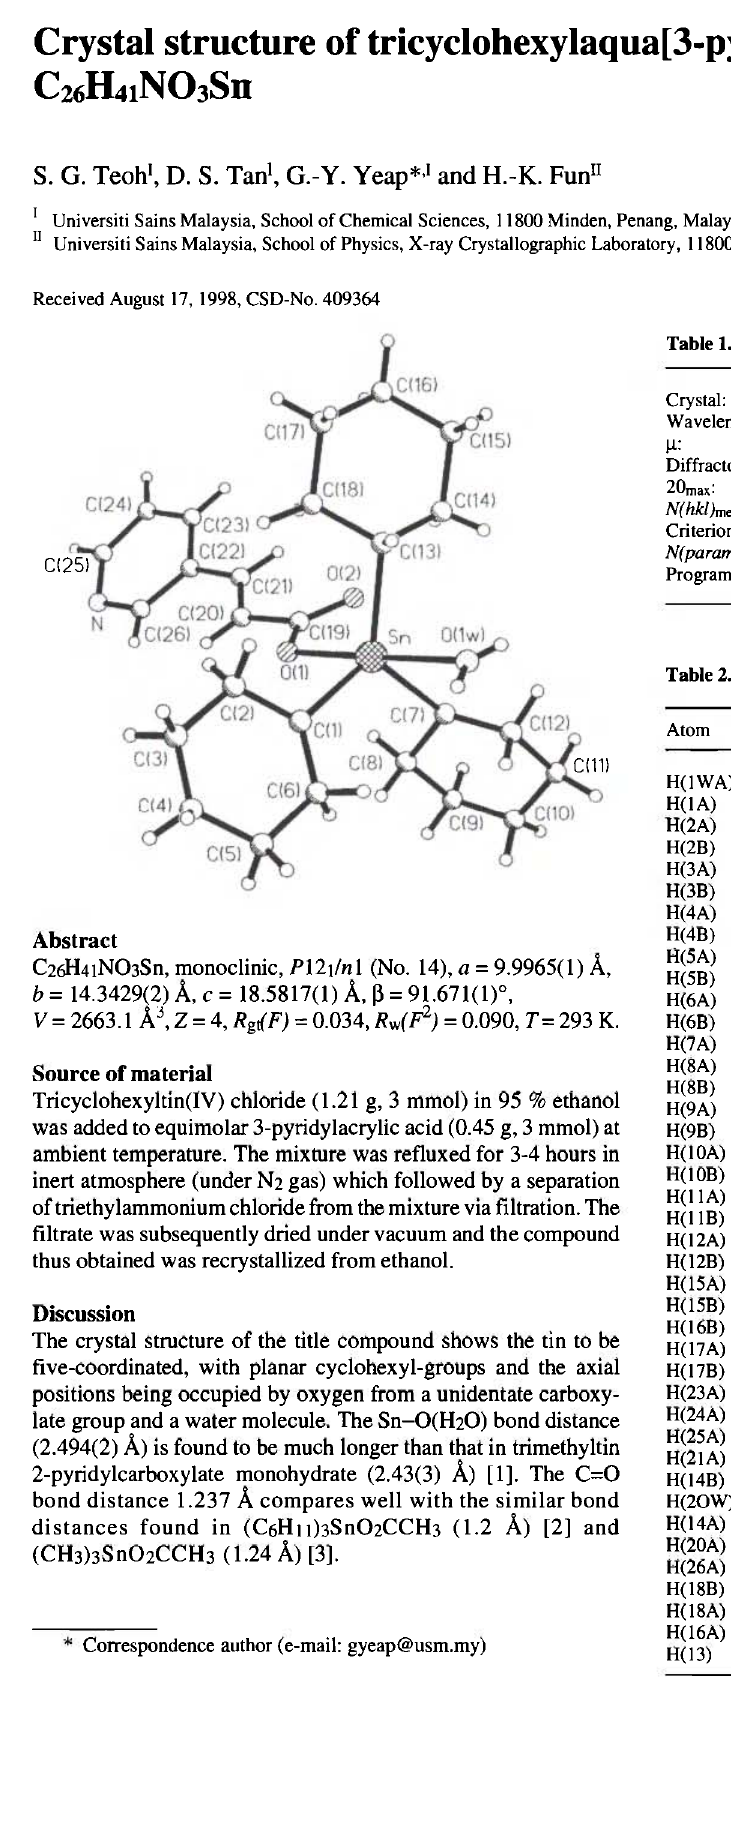
Table 1. Data collection and handling.